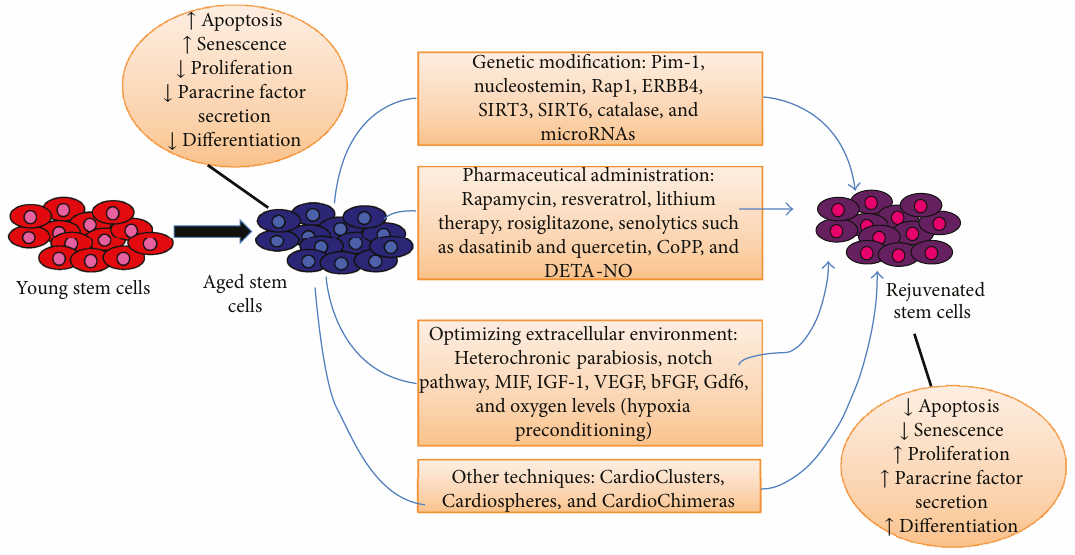
Figure 1: Summary of strategies used to rejuvenate aging stem cells and heal the injured heart. These methods result in an increase in proliferation and decrease in apoptosis and senescence, allowing for improved regeneration capabilities of the myocardium.